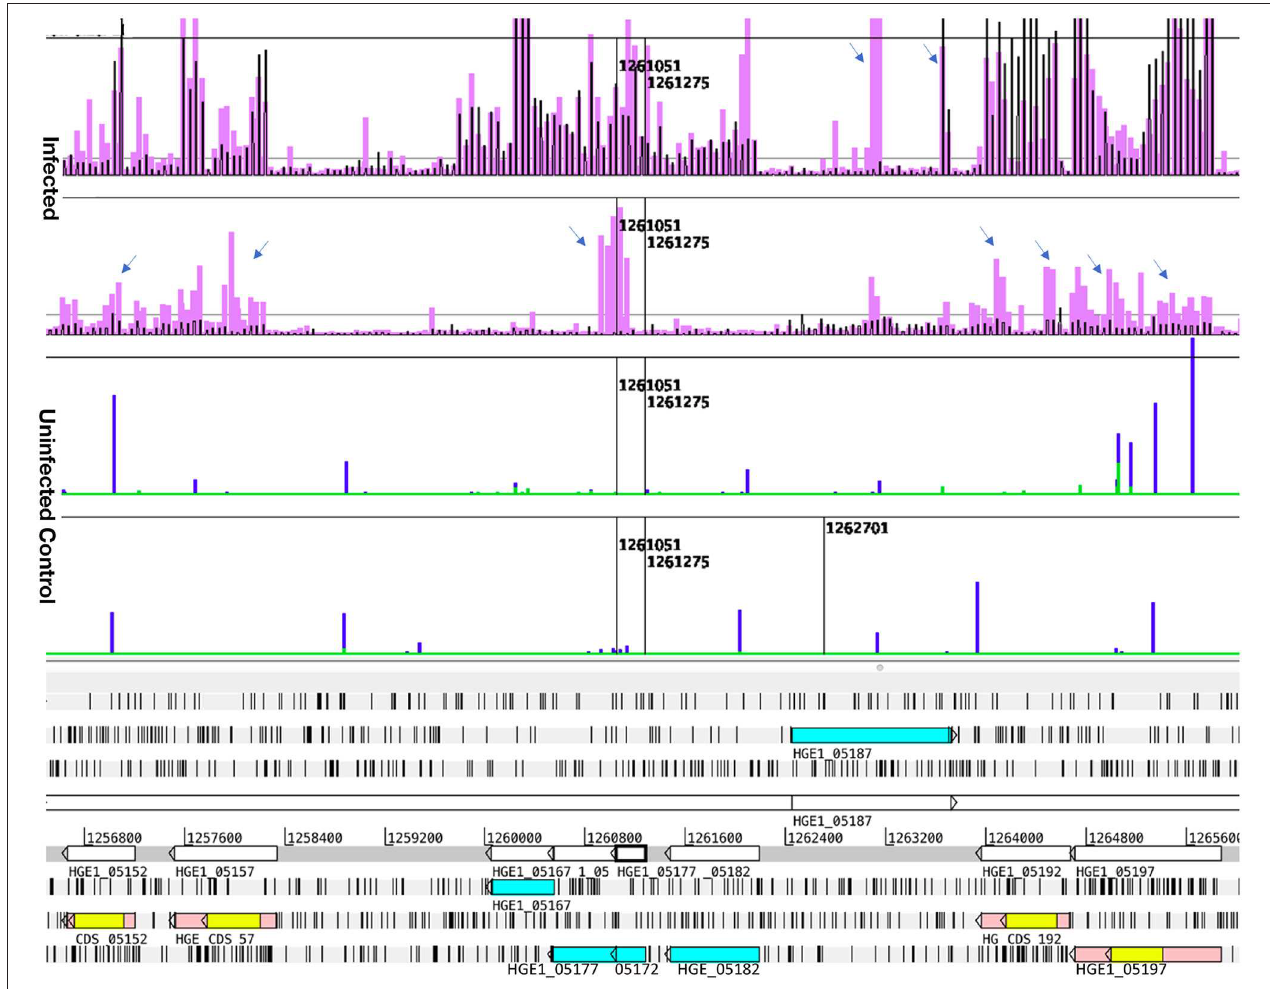
FIGURE 2 | Transcript levels in Sample 1 and sample 3, illustrating differential p44 transcription in HL-60 and ISE6, and antisense transcripts. Transcription data (top four graphs) plotted over the annotated genome sequence (sections at the bottom; turquoise boxes denote coding regions of annotated genes, pink boxes denote p44 conserved sequences with yellow boxes denoting their center hypervariable region) of A. phagocytophilum (Ap) strain HGE1 using the Artemis genome browser. Black bars represent A. phagocytophilum (Ap) transcription in sample 1 (2h with HL-60 cells), and lavender bars transcription signal in sample 3 (2h with ISE6 cells) (Infected). Each bar corresponds to one 60-mer probe on the tiling array. The bottom (Uninfected) graphs depict lack of signal from uninfected controls (HL-60 green, ISE6 blue). Prominent antisense signals in sample 3 are indicated (arrows), especially at the junction of HGE1_05172 (putative ATP synthase FO, B subunit) and HGE1_05177 (ATP synthase subunit C), but also from the p44 paralogs (pink bars with yellow centers) and HGE1_05187. HGE1_05192 ( p44 -18) has strong signal corresponding to its hypervariable region (yellow) indicating that it is specifically transcribed in sample 1. Nucleotide positions in the genome are indicated by numbers above the gray